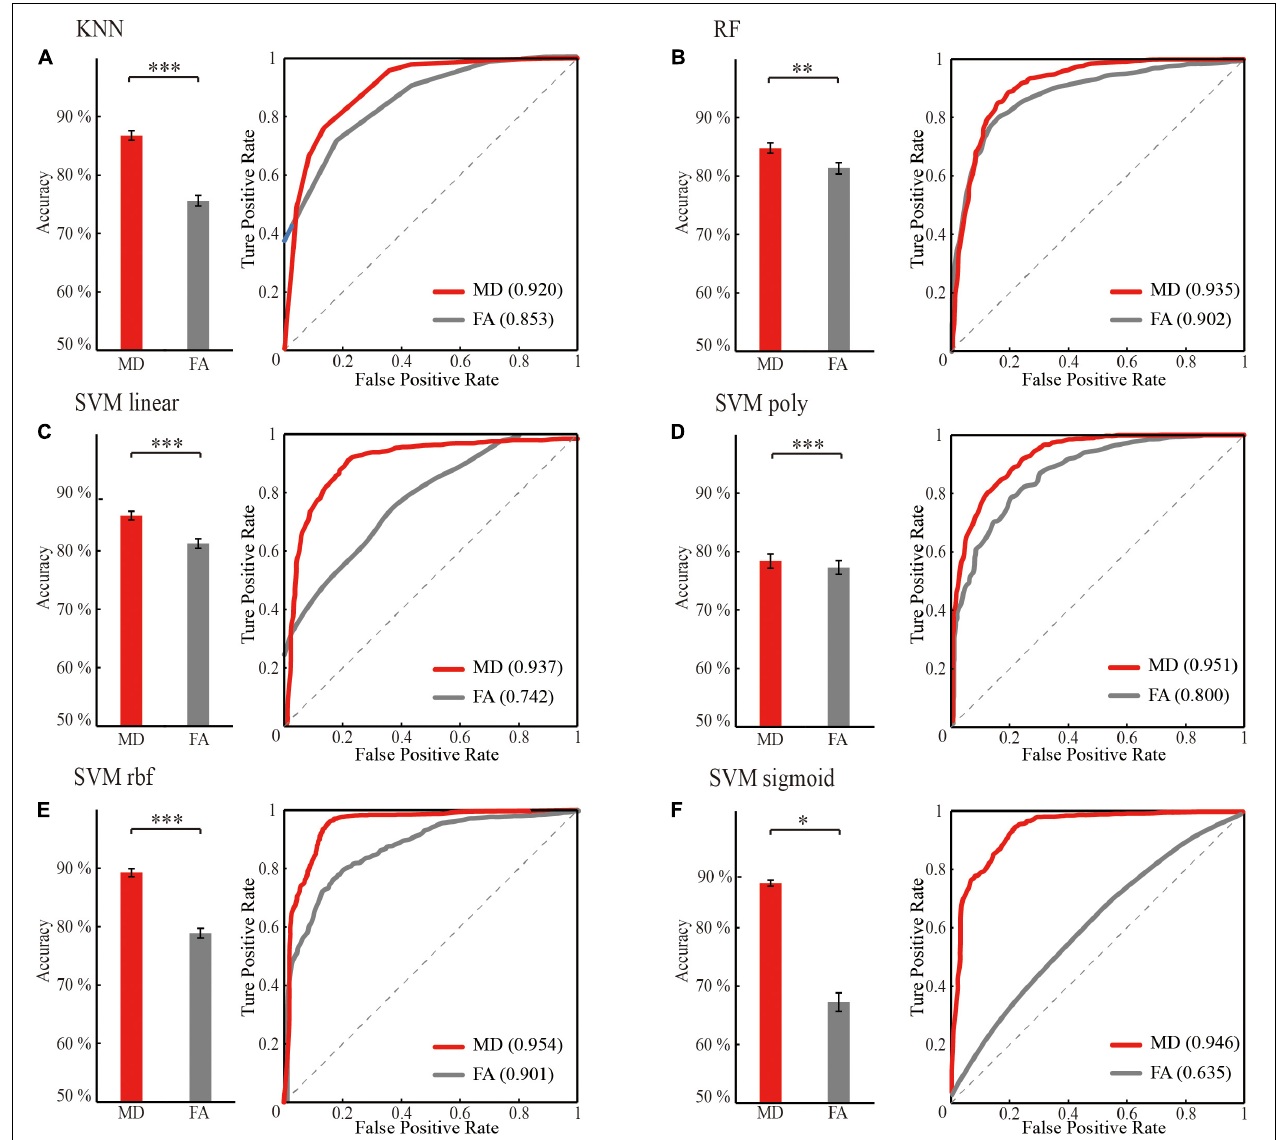
FIGURE 5 | Optimal classification performance comparison between mean diffusivity (MD) and fractional anisotropy (FA) feature sets (the significant HIP related WM network) for different classifier. (A) KNN. (B) RF. (C) SVM linear. (D) SVM poly. (E) SVM rbf. (F) SVM sigmoid. ‘red’: classification performance of mean diffusivity feature sets; ‘gray’: classification performance of fractional anisotropy feature set. Classification performance including mean accuracy (mean ± std; * p < 0.05, ** p < 0.005, and *** p < 0.0005; rank sum test with Bonferroni correction) and AUC of randomly 100 times hold out